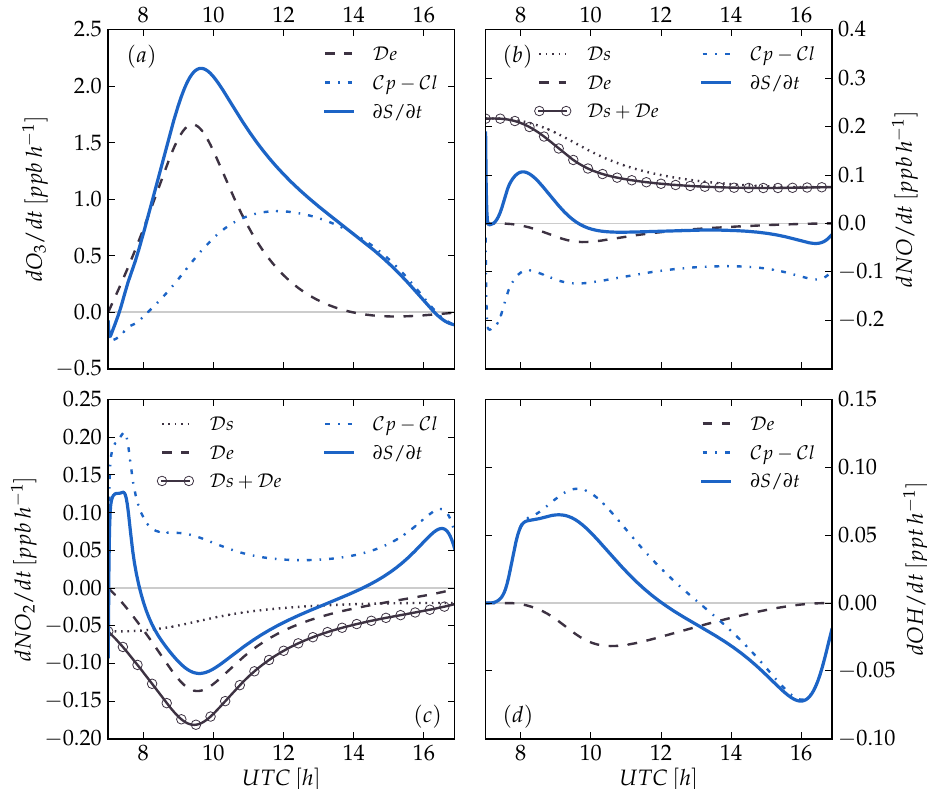
Fig. 6. Individual budget terms of Eq. (8) for O 3 , NO, NO 2 and OH. The labels of the individual terms refer to the notation defined in Eq. (8).